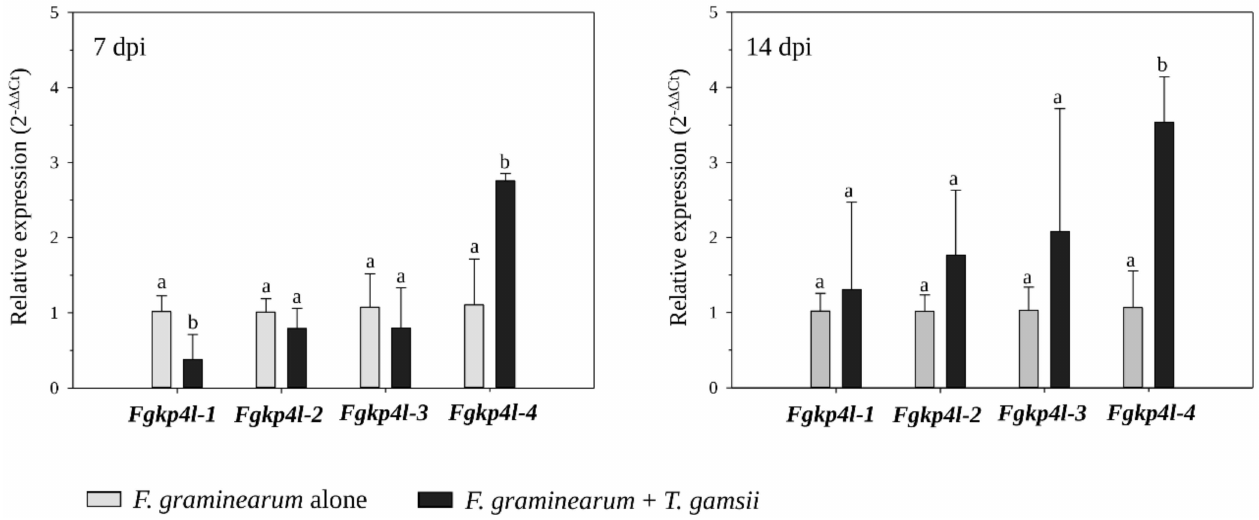
Figure 3. Gene expression profiles of Fgkp4l genes during the interaction with T. gamsii on wheat spikes. Total RNA was extracted from wheat spikes colonized by F. gramineraum alone (basal condition 2 − ∆∆ Ct = 1) and colonized by both the pathogen and T. gamsii at 7 dpi and 14 dpi with the pathogen. The actin gene was used as an endogenous control for data normalization. The values are the mean of three independent biological replicates with the corresponding standard deviation. Fold change in sample relative to control is expressed as 2 − ∆∆ Ct . The different letters correspond to statistically different values for p ≤ 0.05